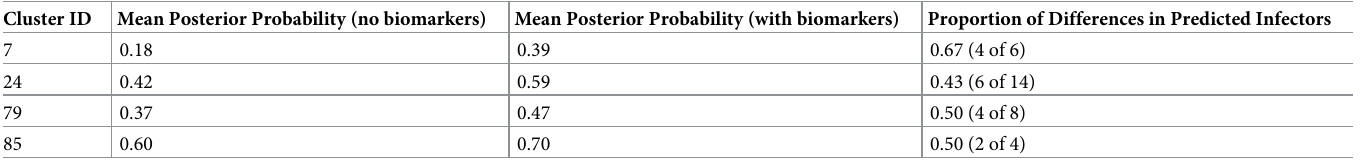
Table Footnote: Cluster 7 is shown in S6 Fig, cluster 24 in Fig 8B, cluster 79 in S7 Fig, and cluster 85 in Fig 8B.